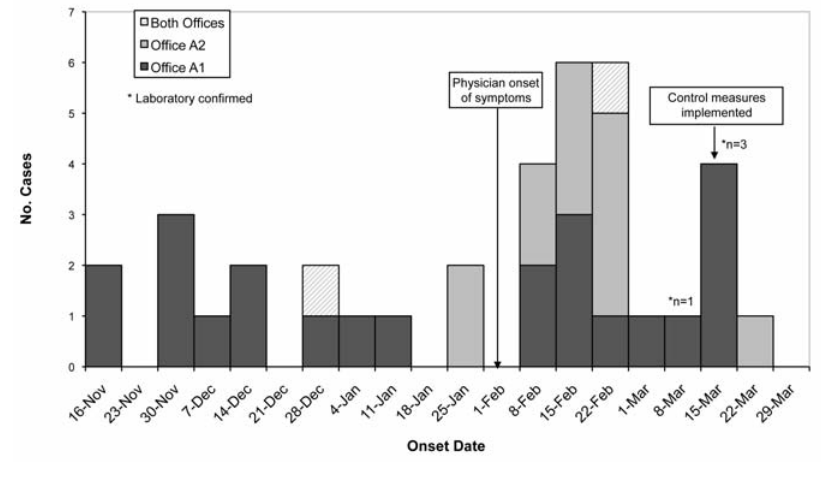
Figure 1. Epidemiologic curve of epidemic keratoconjunctivitis patients seen at practice A by office location.